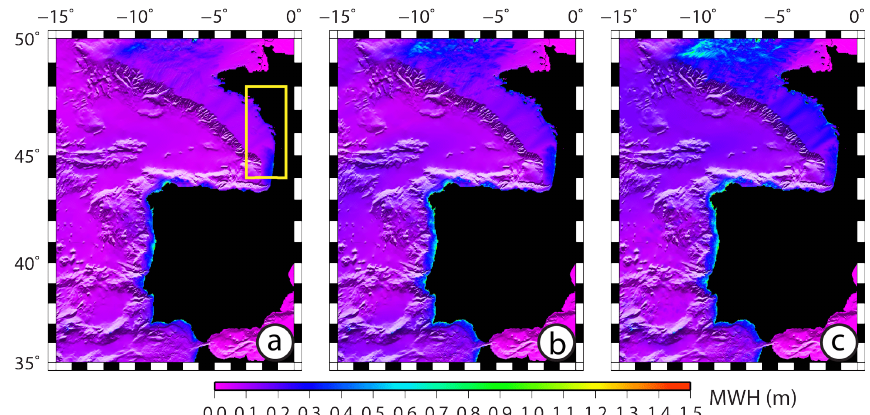
Figure 7. Maximum wave height maps obtained after 12h of propagation showing coastal amplifications close to the French, Portuguese and Spanish coastline (grid 5) for the 3 scenarios. From left to right, scenarios 1 (a) , 2 (b) , and 3 (c) . The yellow rectangle shows the position of the grid 6.